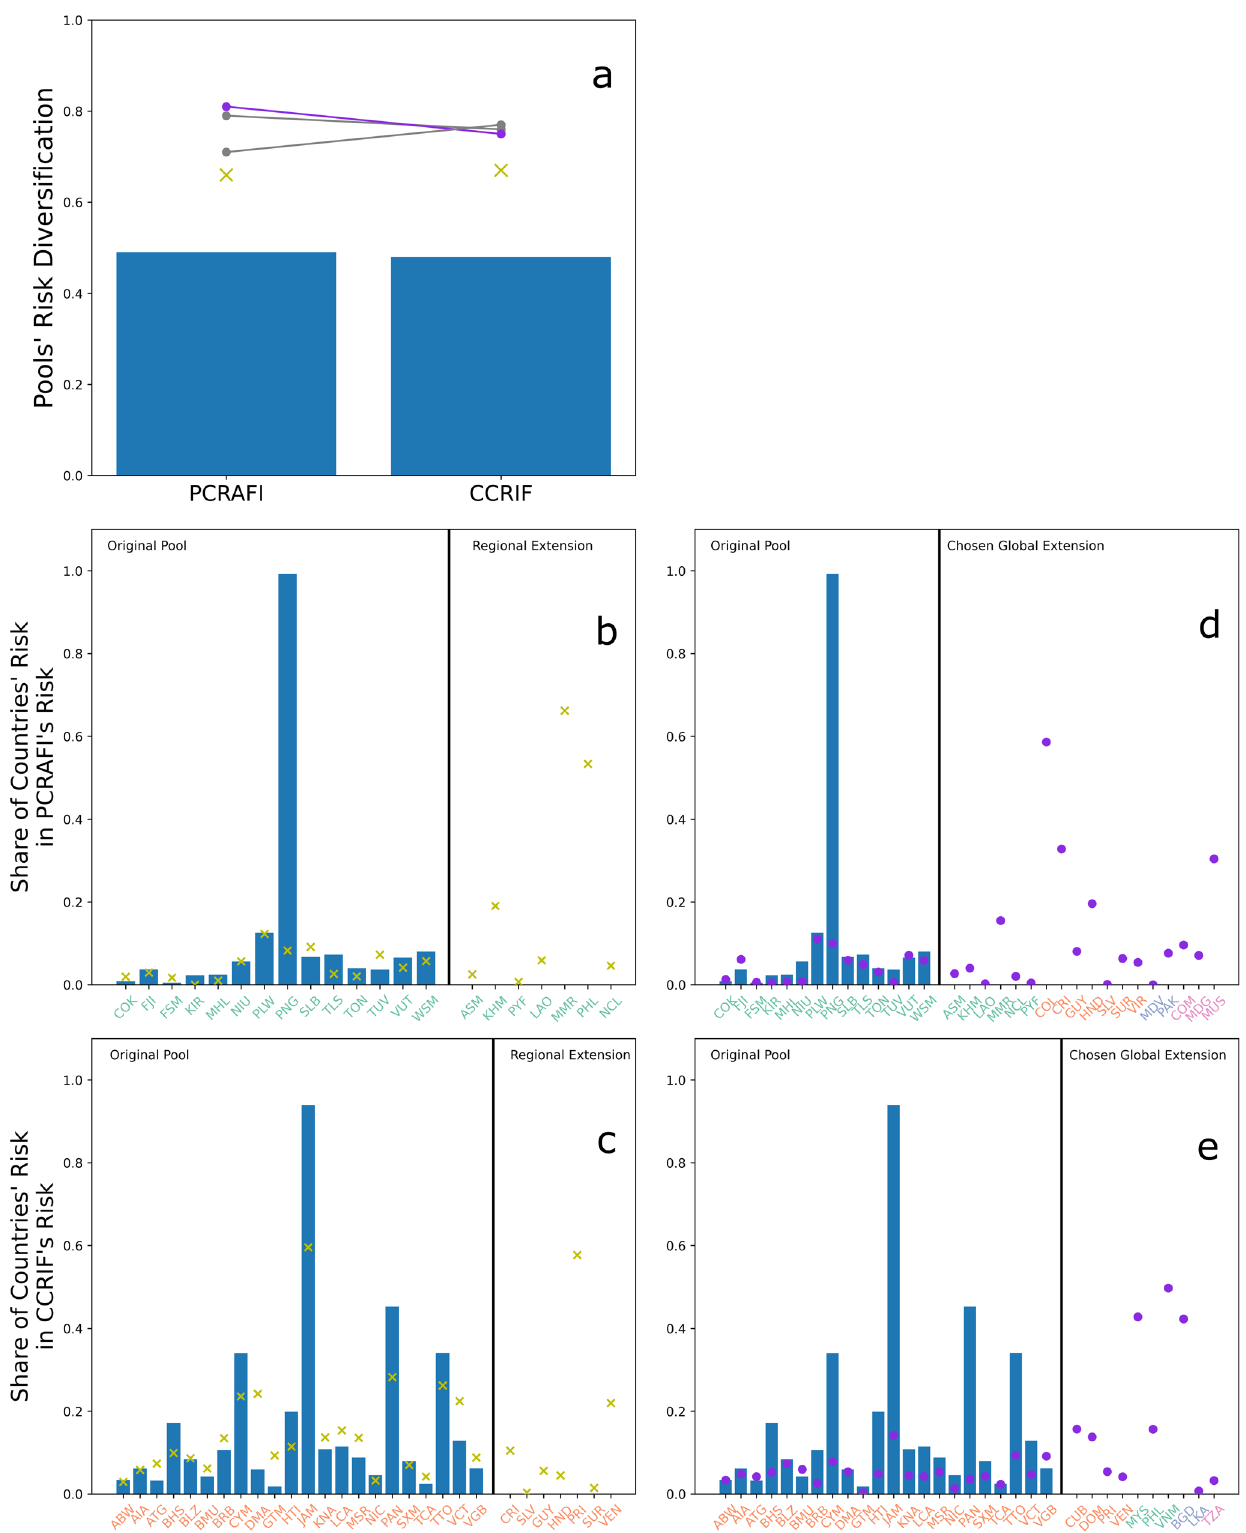
Fig. 3 | Results of the regional and global optimal extensions of the Paci fi c Catastrophe Risk Assessment and Financing Initiative (PCRAFI) and the Car- ibbeanCatastropheRiskInsuranceFacility(CCRIF).a showsriskdiversi fi cations of the original pools (bars), the regionally (yellow cross) and globally (solid lines) diversi fi ed pools. Regarding the latter, all Pareto optimal con fi gurations are reported in gray and the selected one (namely the one leading to the highest diversi fi cation for PCRAFI) is highlighted in purple. b – e show the shares of